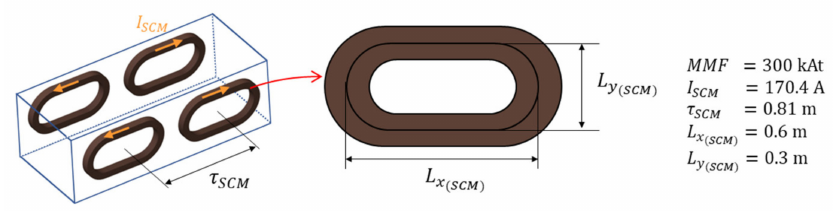
Figure 10. Configuration of a bogie with 2 poles and 2 modules of the SCMs for the small-scale Hyperloop testbed.